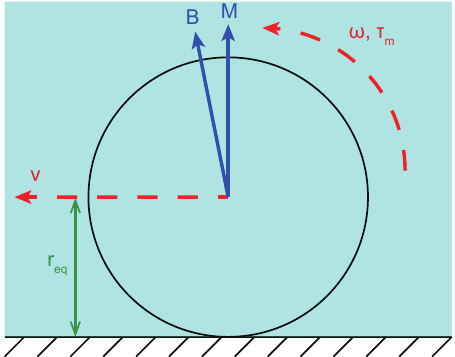
Figure 2. Free-body diagram of a rolling